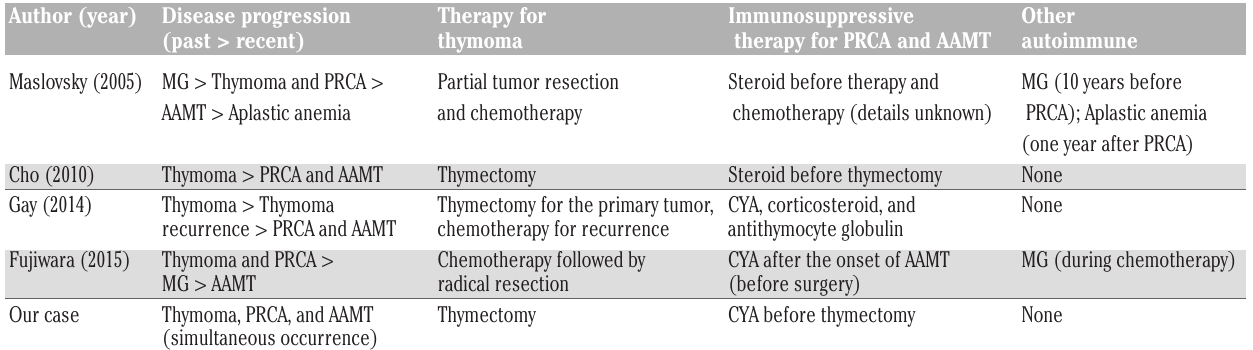
Table 1. Published cases of combined thymoma, pure red cell aplasia, and acquired amegakaryocytic thrombocytopenia. Author (year) Disease progression